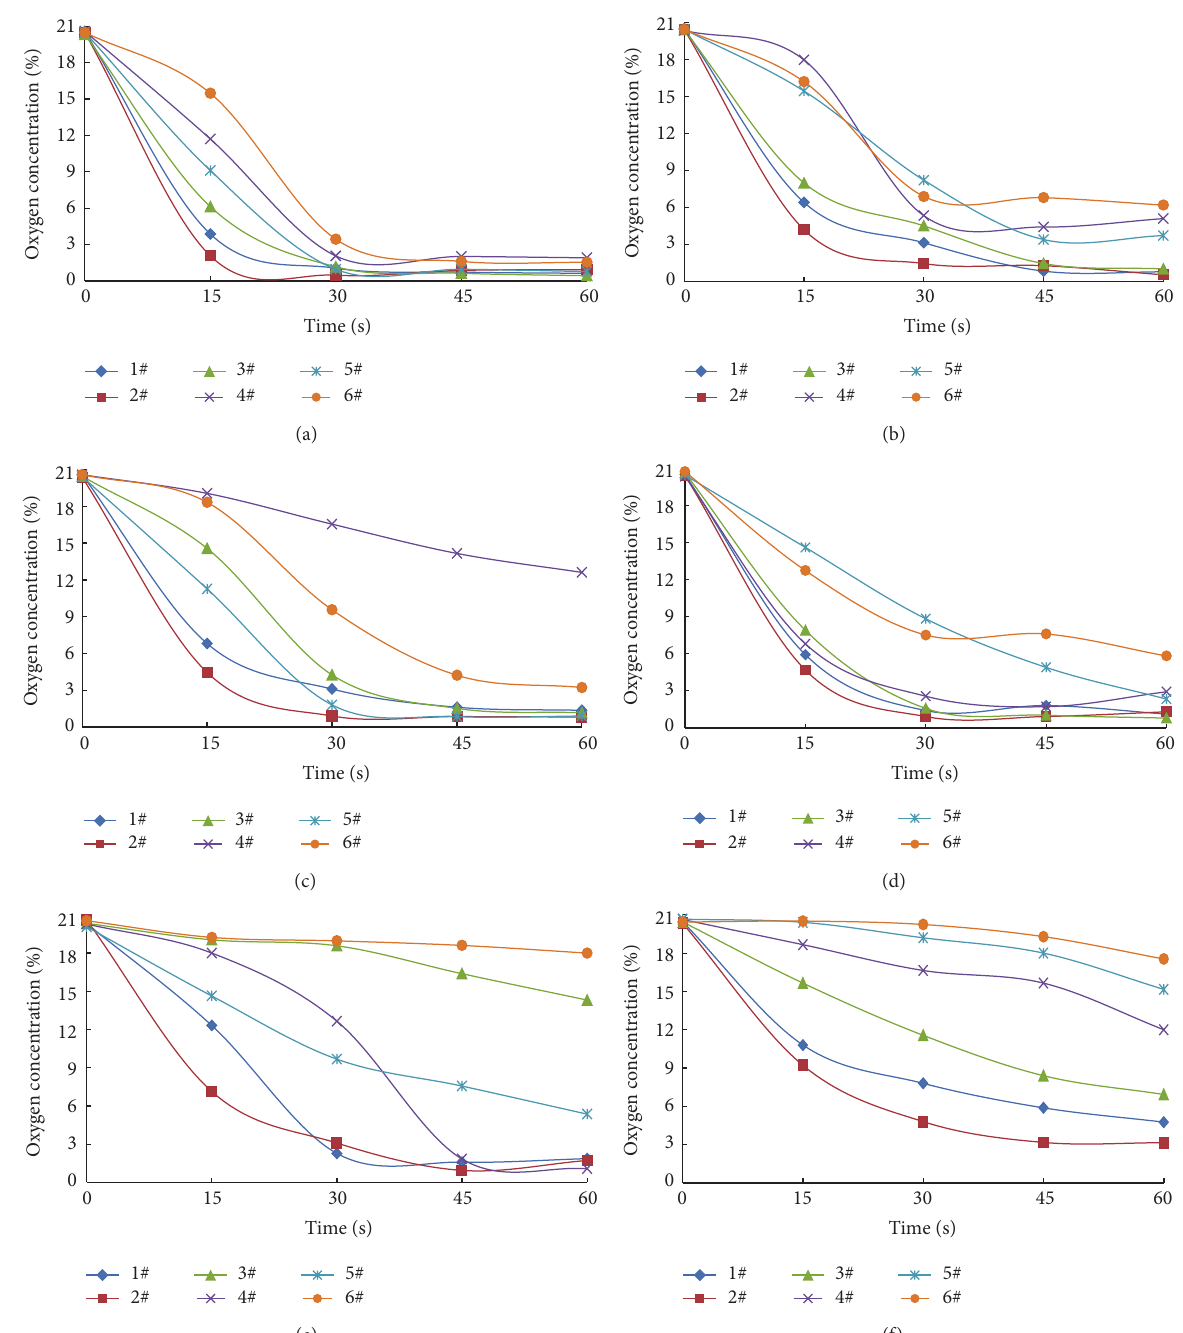
Figure 3: Oxygen concentration variation of measuring points dependent on the